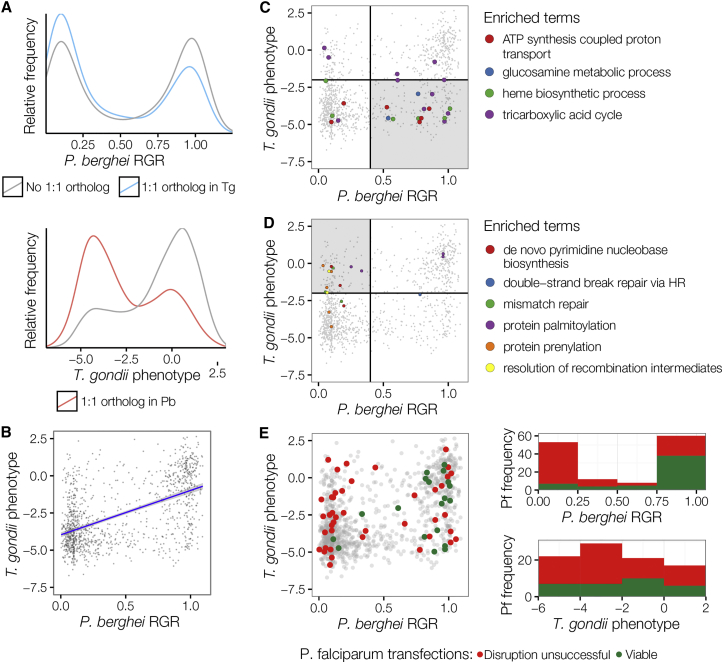
Comparison of Phenotypes for Orthologous Genes across Three Apicomplexan Species(A) The distribution of 1:1 orthologous genes in P. berghei and T. gondii (data from Sidik et al., 2016) is significantly shifted toward essentiality as compared to non-shared genes.(B) There is highly significant correlation of phenotypes between species for orthologous genes, but there are also numerous genes without conserved phenotypes.(C) All significantly enriched GO terms among genes that are more dispensable in P. berghei (shaded area).(D) Same as in (C) but for genes more dispensable in T. gondii (shaded area).(E) Left: data as in (B) but overlaid with published P. falciparum phenotypes (Sanderson and Rayner, 2017). Right: data from pairwise comparisons. P. falciparum phenotypes are color coded (green, viable mutant; red, confirmed essential or disruption failed).See also Table S5.